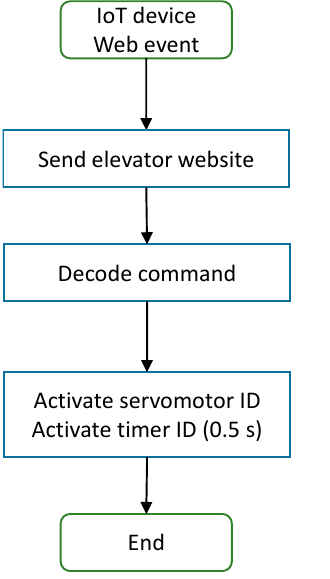
Figure 10. IoT device software flow chart.